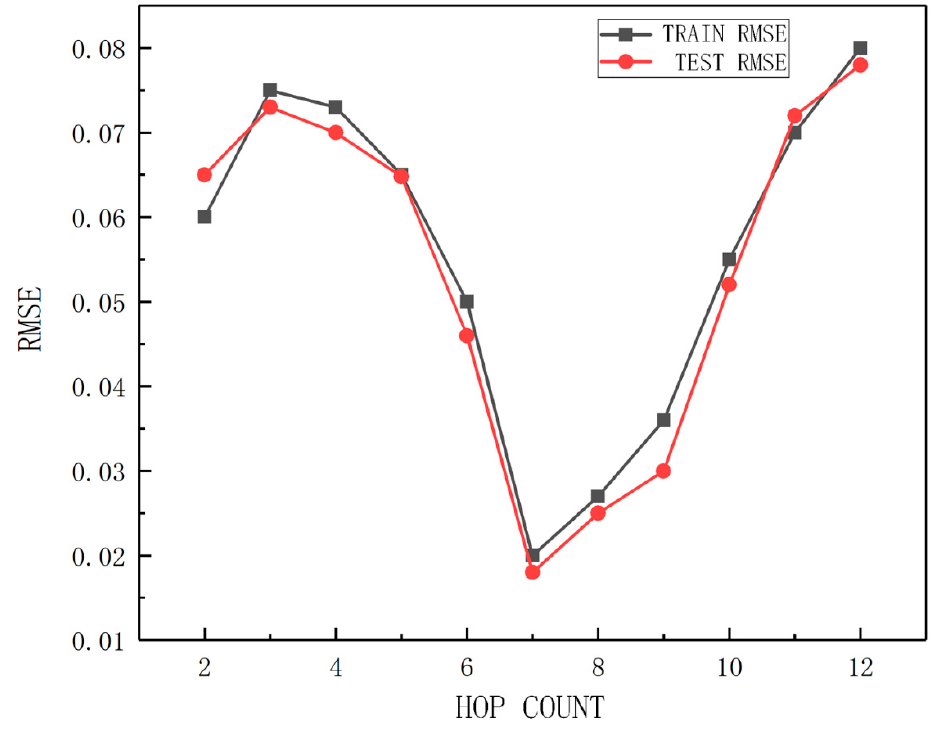
Figure 6. Graph of relationship between nodes and errors.